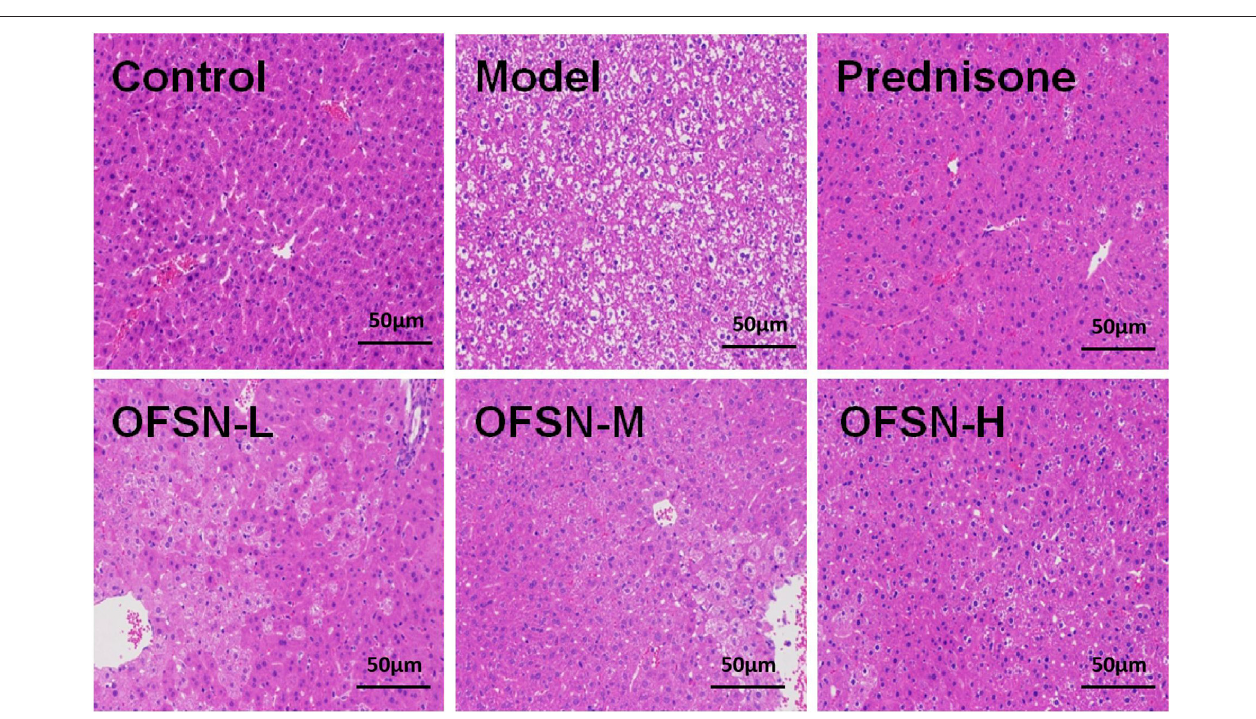
FIGURE 5 | Pathological changes of liver tissues (HE staining, ×